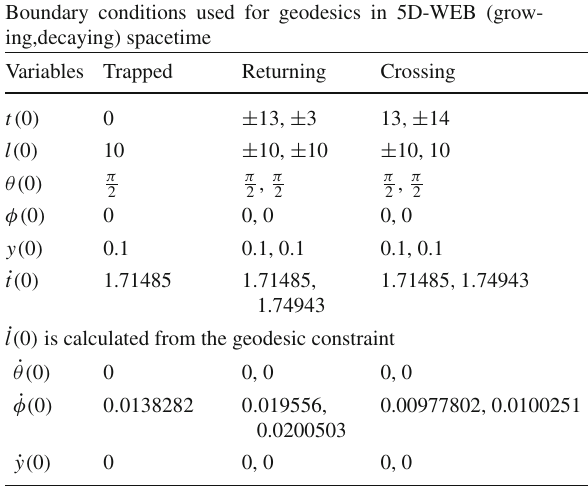
Table 2 Boundary values used for Figs. 9 and 10 Boundary conditions used for geodesics in 5D-WEB (grow- ing,decaying) spacetime Variables